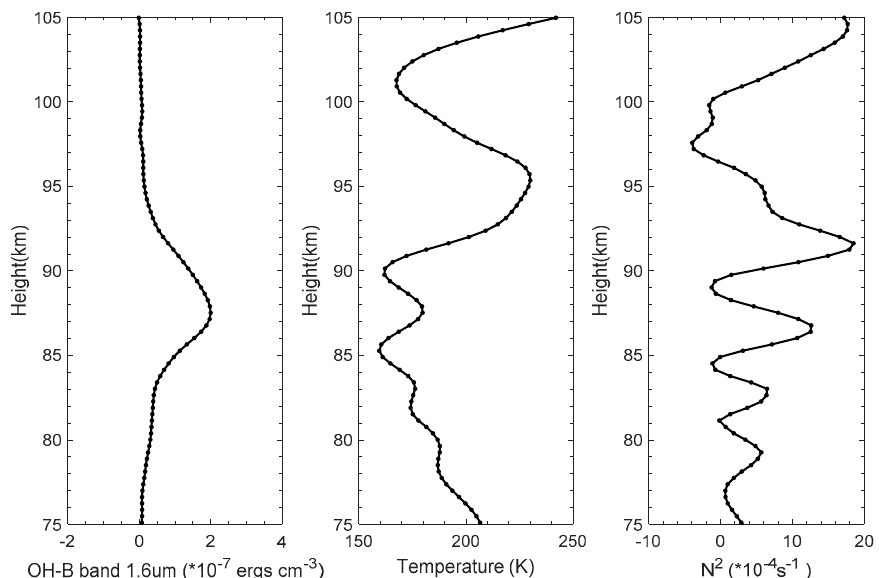
Figure 6. Averaged vertical profiles of OH emission, temperature and square of the Brunt–Vaisala frequency ( N 2 ) obtained by Sounding of the Atmosphere using Broadband Emission Radiometry (SABER) measurements from 06:59 to 07:06 UT, 2 h prior to mesospheric bore onset on 4 May 2014.